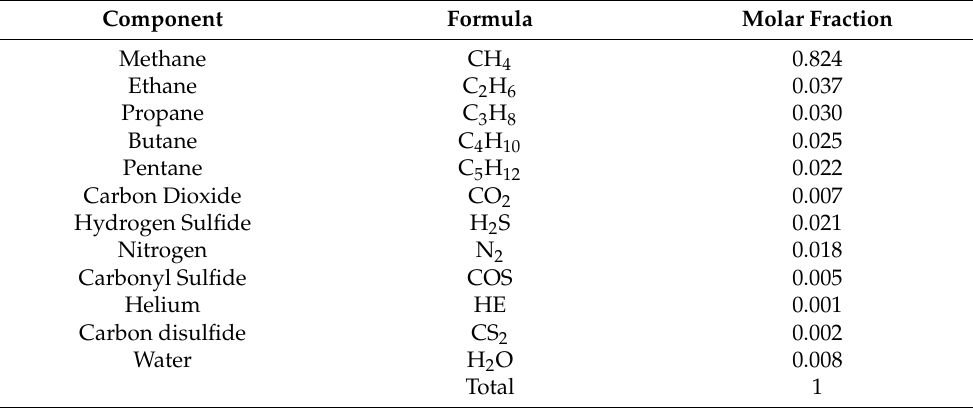
Table 1. Gas composition in a petroleum field in the VMM basin in Colombia. Component Formula Molar Fraction Methane CH 4 0.824 Ethane C 2 H 6 0.037 Propane C 3 H 8 0.030 Butane C 4 H 10 0.025 Pentane C 5 H 12 0.022 Carbon Dioxide CO 2 0.007 Hydrogen Sulfide H 2 S 0.021 Nitrogen N 2 0.018 Carbonyl Sulfide COS 0.005 Helium HE 0.001 Carbon disulfide CS 2 0.002 Water H 2 O 0.008